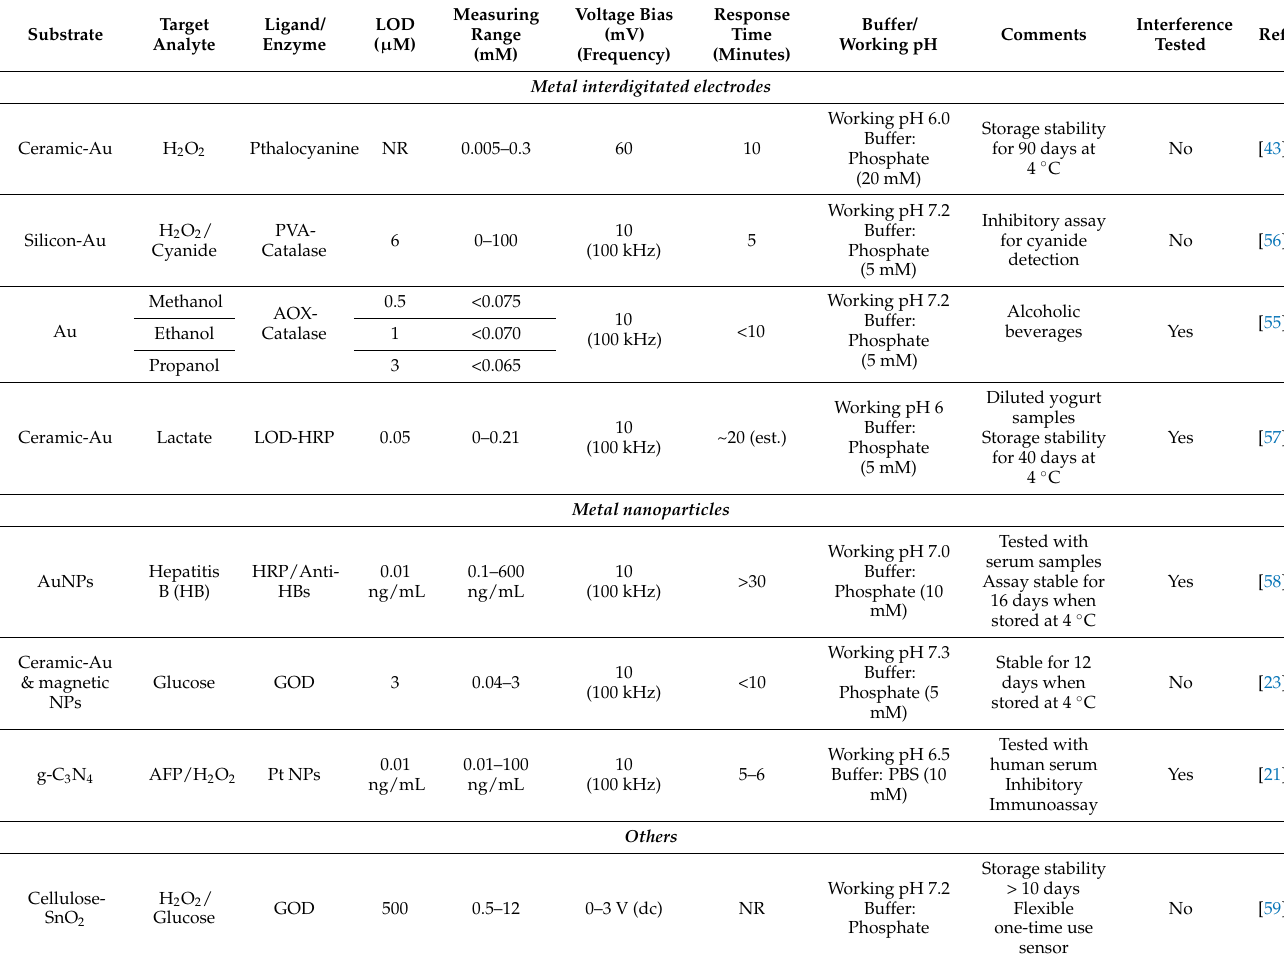
Table 2. Summary of H 2 O 2 conductometric sensors with the crucial sensor properties including LOD, measuring range, voltage bias, response time, buffer and working pH. Where AOX: Alcohol oxidase, PVA: Polyvinyl alcohol, g-C 3 N 4 : graphitic carbon nitride, Au: Gold, AuNPs: Gold nanoparticles, AFP: alpha-fetoprotein, LOD: Lactate